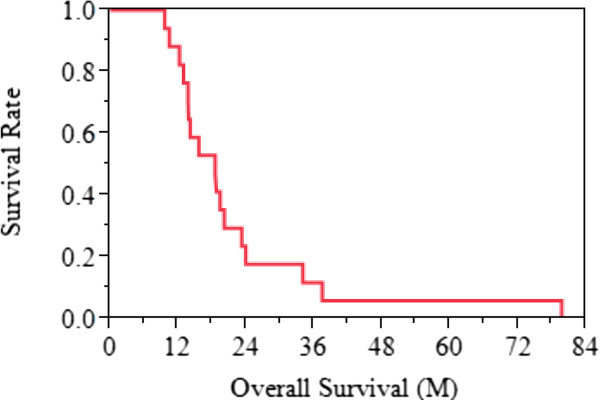
Overall survival of all patients: Median overall survival was 18.5 months (95% CI; 12.9 - 23.2 months).